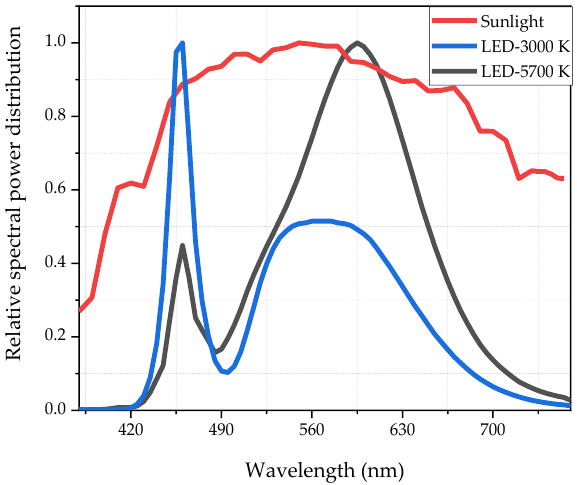
Figure 4. The relative spectral power distributions (SPDs) of 3000 K-LED, 5700 K-LED and sunlight measured at 1 pm.